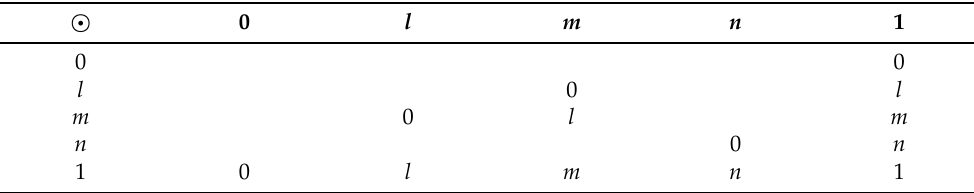
Figure 1. Lattice order relation on L . Table 3. The partial operation (cid:12)